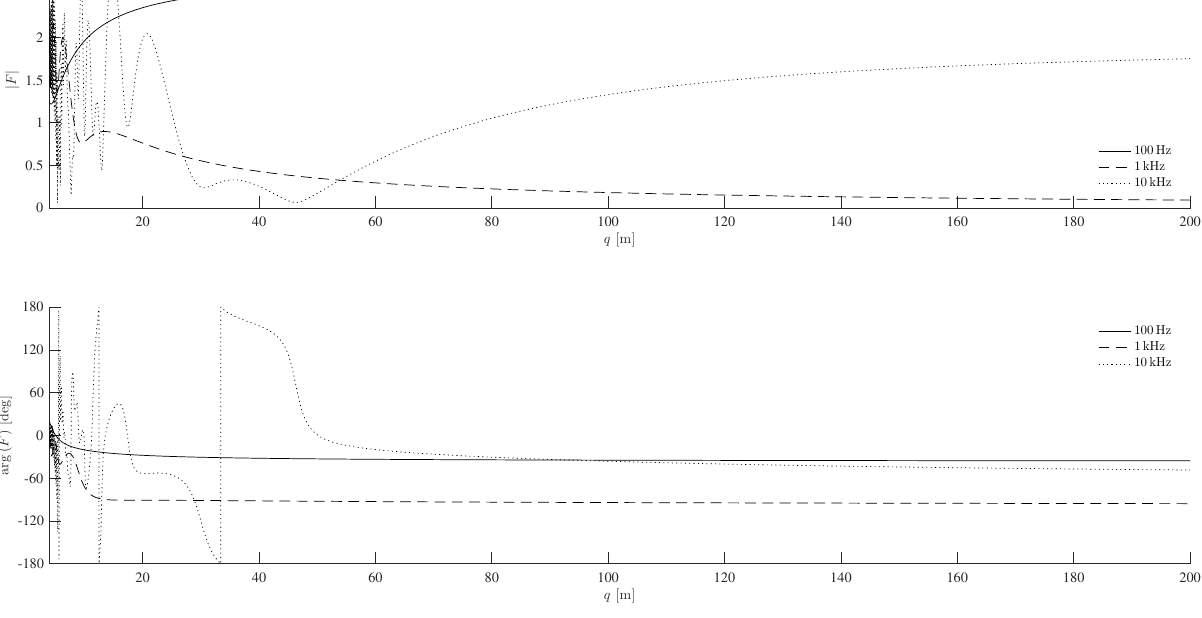
Figure 8: Modulus (top) and phase (bottom) of the multipath factor (18) versus source distance, 4m < q < 1400m , in a fixed direction, β = 2.45 °, with rigid ground and wall, R h = R v = 1 , and observer position at ( a , b ) = (3, 2) m , adding to the frequency f = 1000Hz two others, one with larger order of magnitude, f = 10000Hz , and one with smaller order of magnitude, f = 100Hz .